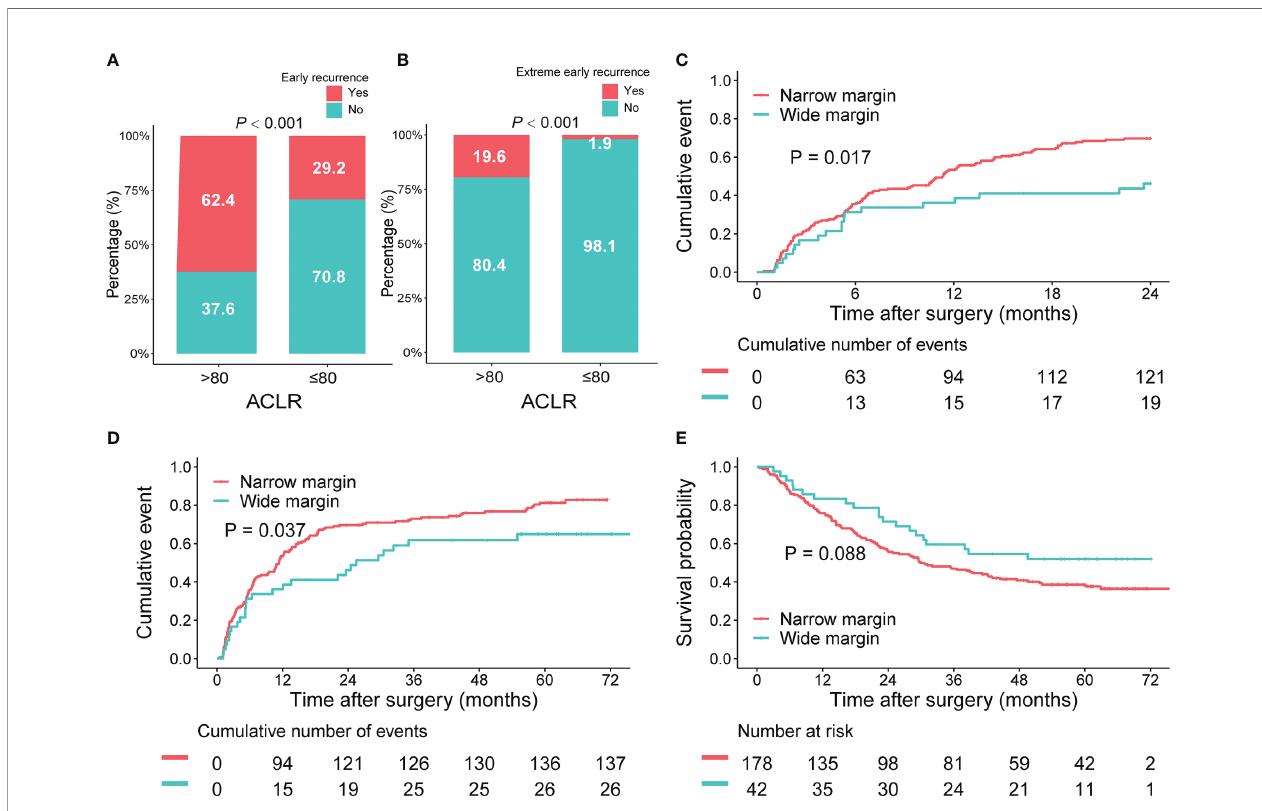
FIGURE 4 | Implications of ACLR for early recurrence and resection margin for patients with HCC of the whole cohort. (A, B) Comparison of (A) early recurrence and (B) extreme early recurrence rates between patients with HCC with high and low ACLR. (C – E) Kaplan – Meier analysis of 2-year cumulative recurrence rate (C) , TTR (D) , and OS (E) for patients with HCC with high ACLR, strati fi ed by the resection